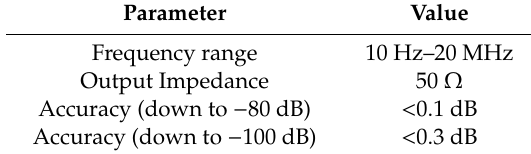
Table 3. Frequency response analysis (FRA) equipment’s main characteristics.